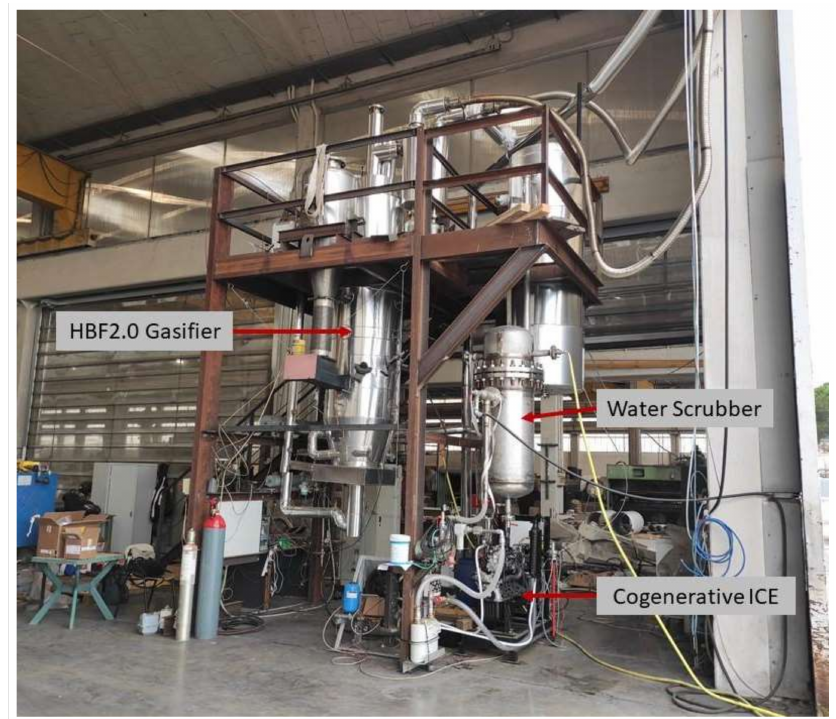
Figure 3. Picture of pilot